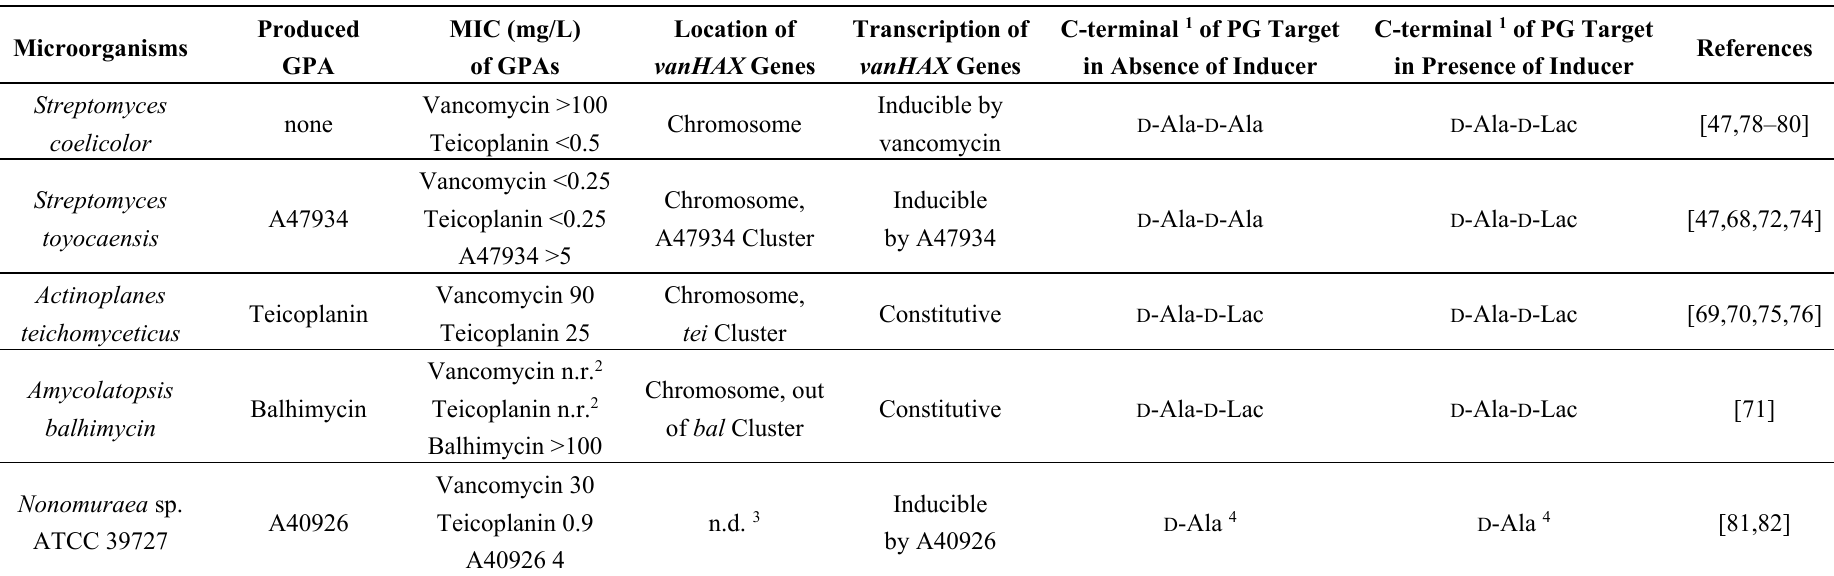
Table 3. Features of GPA-resistance in